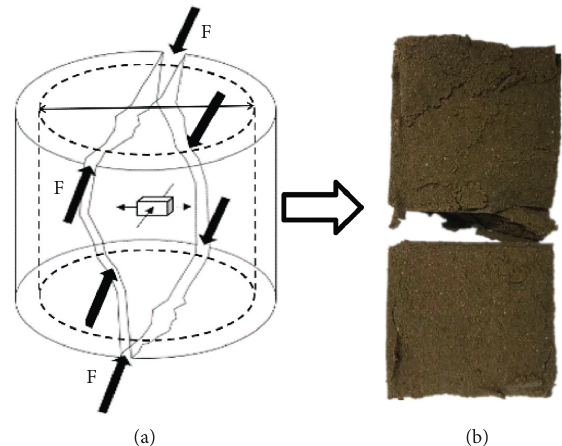
Figure 9: STS tensile failure mode and morphology. (a) Stress state. (b) Failure